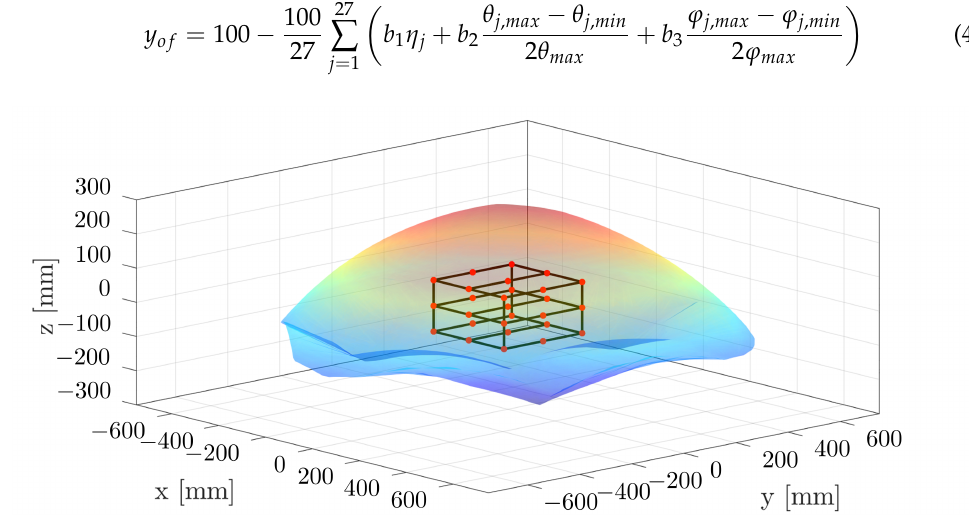
Figure 13. Red points are for evaluation of the performance indicators.